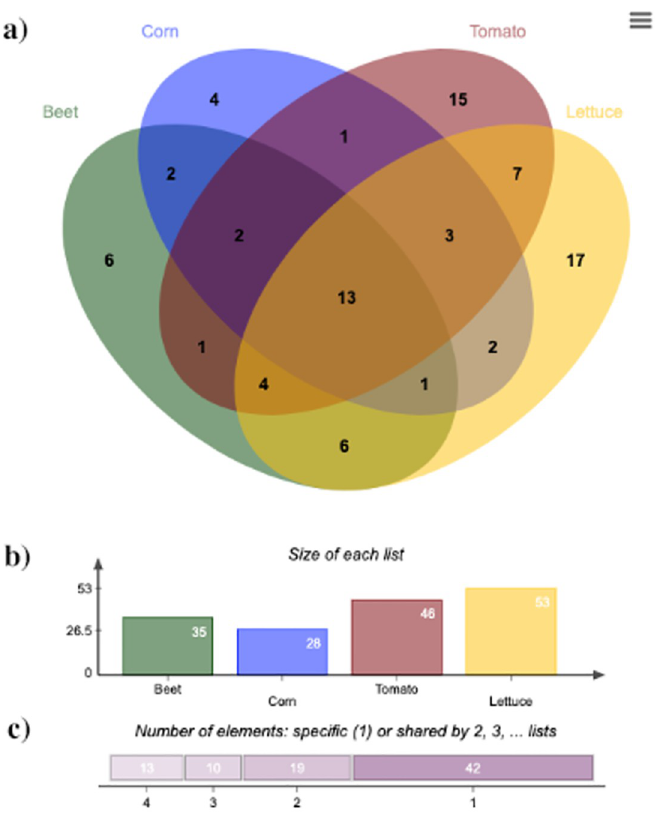
Fig 6. Venn diagram displaying the shared and unique bacterial reads from pooled crop rhizospheres after disruption. The list of full crop-shared or crop specific bacterial reads can be visualized in S10 Table. (A) Venn diagrams noting the number of shared or specific genera for each crop (green = beet, blue = corn, red = tomato, yellow = lettuce). (B) Bar graph showing the size of bacterial increased in abundance by each crop after disruption. (C) Display showing the number of bacterial reads unique to one (42) or shared by two, three or four crops (19, 10, 13, respectively). Figure created using jvenn